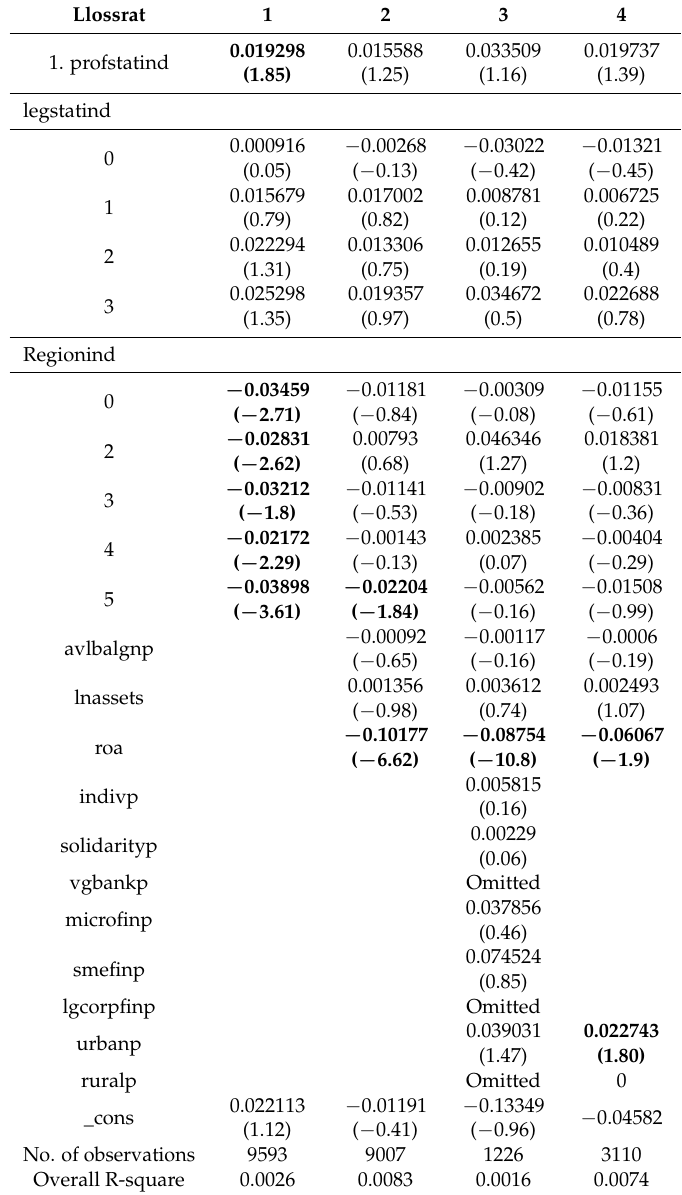
Table A2. Loan loss rate panel